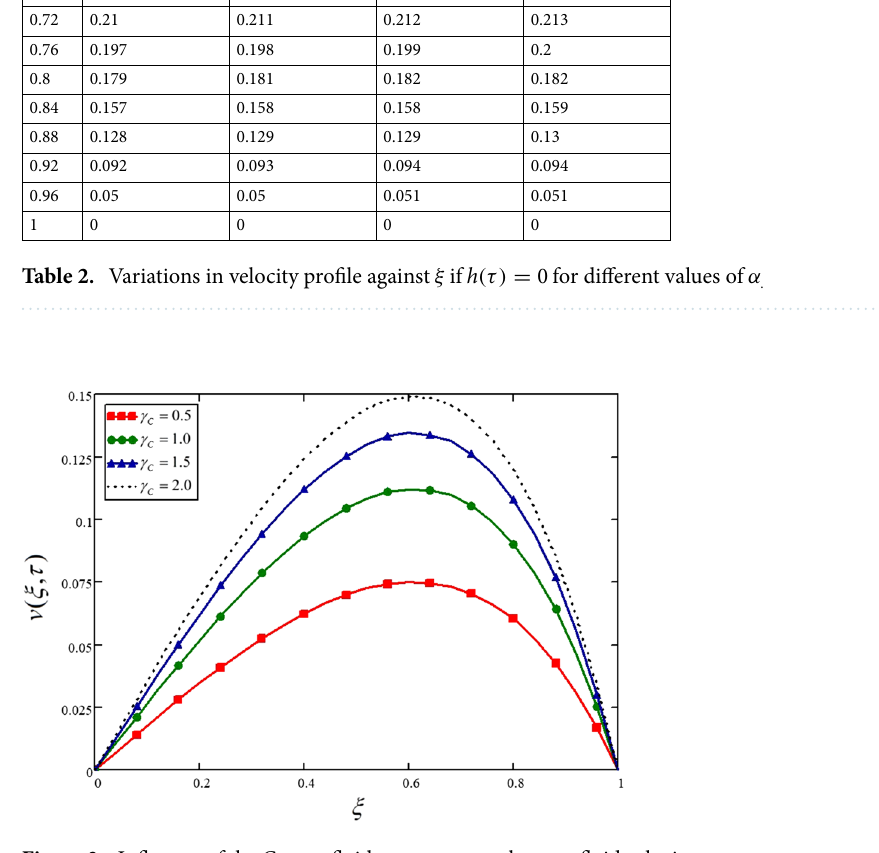
Figure 3. Influence of the Casson fluid parameter on the nanofluid